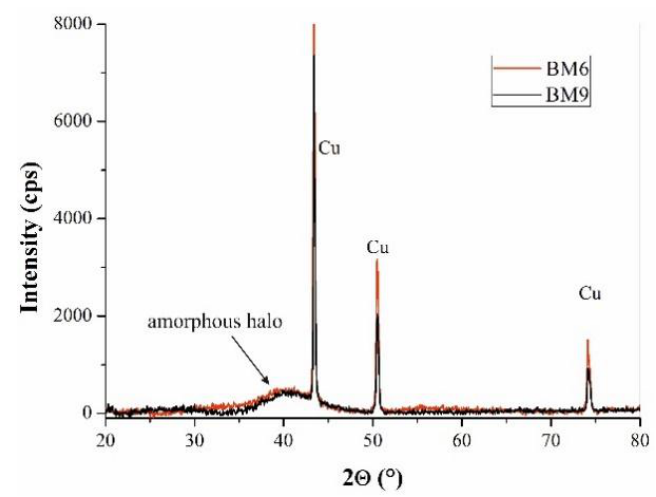
Figure7. XRD patterns of composites after hot pressing.